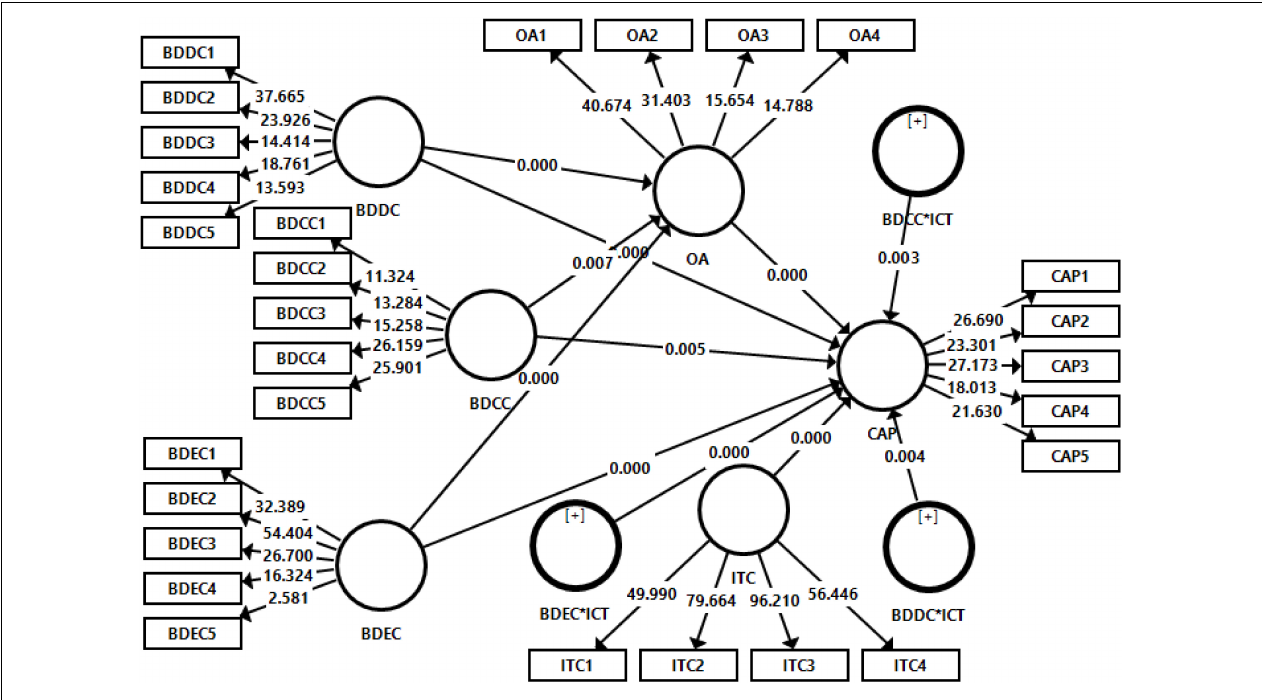
FIGURE 2 | Structural model assessment. Table 4 indicates the direct effects hypotheses estimation results. Findings indicated that big data contextualization capability has a positive and significant effect on CAP ( β = 0.195, t = 2.849) and big data democratization capability also positively